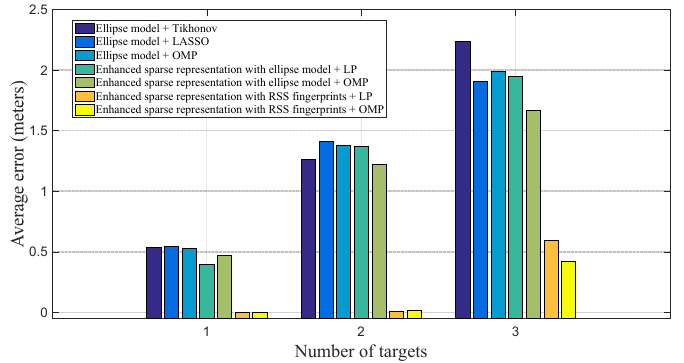
Figure 9. Average localization accuracy in the indoor NLOS scenario.